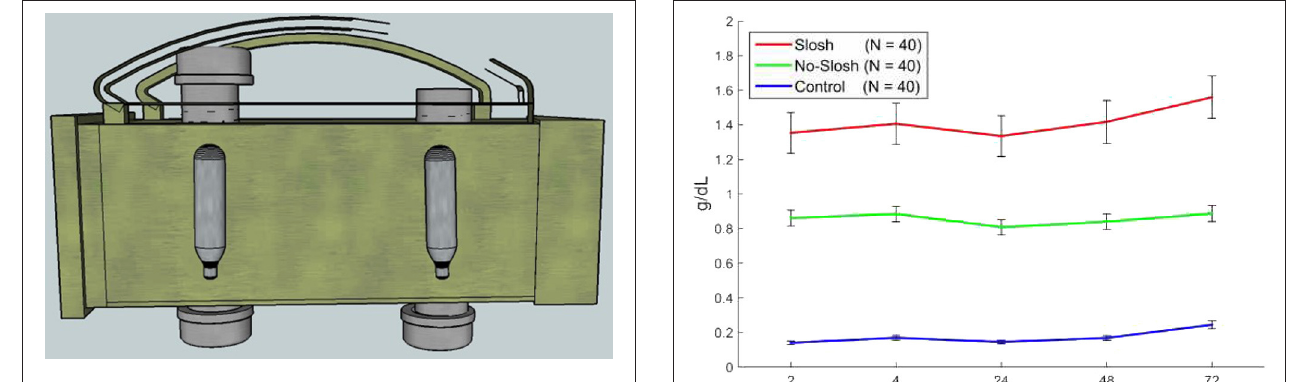
FIGURE 3 | Cut-away view showing the positioning of the steel CO 2 cartridges inside the blast chambers. Two chambers were constructed to expedite the blasting process.